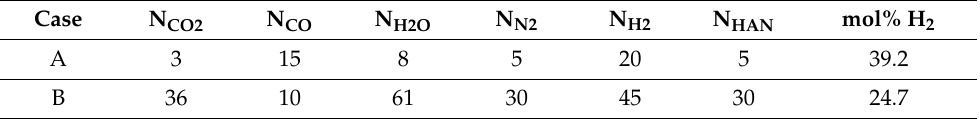
Table 4. Product mole numbers and HAN mole numbers for Case A (see Equation (5)) and Case B (see Equation (30)). The last column gives the mole % hydrogen consistent with the mole numbers of